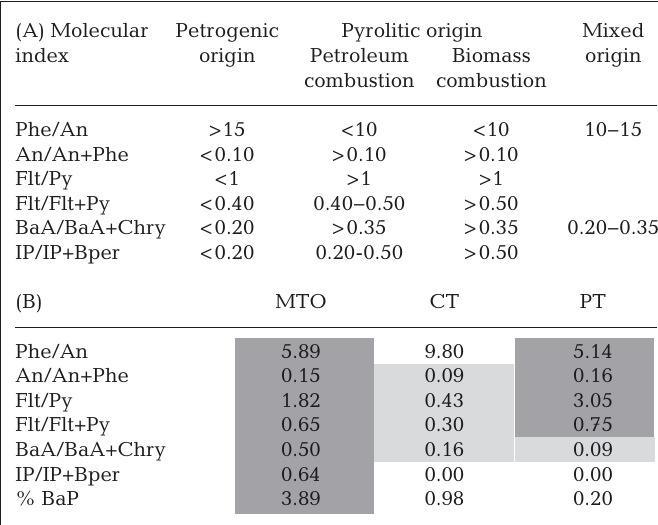
Table 3. Molecular indices used as fingerprints to determinate the origin of hydrocarbons. (A) Characteristic values indicative of the pyrolytic or petrogenic origin of a hydrocarbon (Colombo et al. 1989, Budzinski et al. 1997, Baumard et al. 1998a,b, Soclo et al. 2000, Yunker et al. 2002a,b). (B) Values of these molecular indices of 3 different tars used in cleaning of mussel rafts. MTO: mixture of petroleum tars and diesel combusted oil; CT: coal tar; PT: tar of pine wood; ( j ) petro- genic origin; ( j ) pyrolitic origin; (no shading) mixed origin.